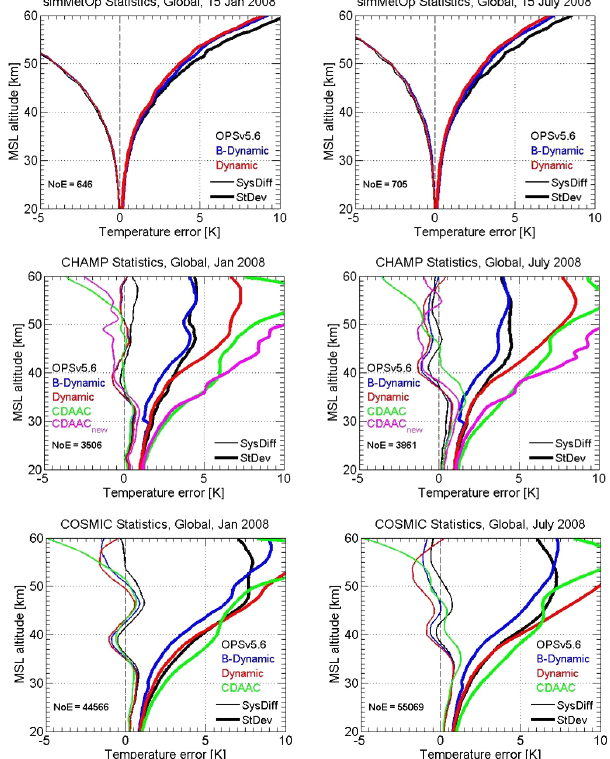
Figure 14. Systematic differences (SysDiff, light lines) and stan- dard deviations (SD, heavy lines) of retrieved temperature profiles, relative to “perfect” simulated temperature or co-located ECMWF analysis temperature used as a reference, for the global ensemble of simMetOp events on 15 January and 15 July 2008 (top panels) and of CHAMP events (middle panels) and COSMIC events (bottom panels) from the full months of January and July 2008. The figure layout is the same as for Figs. 8 and